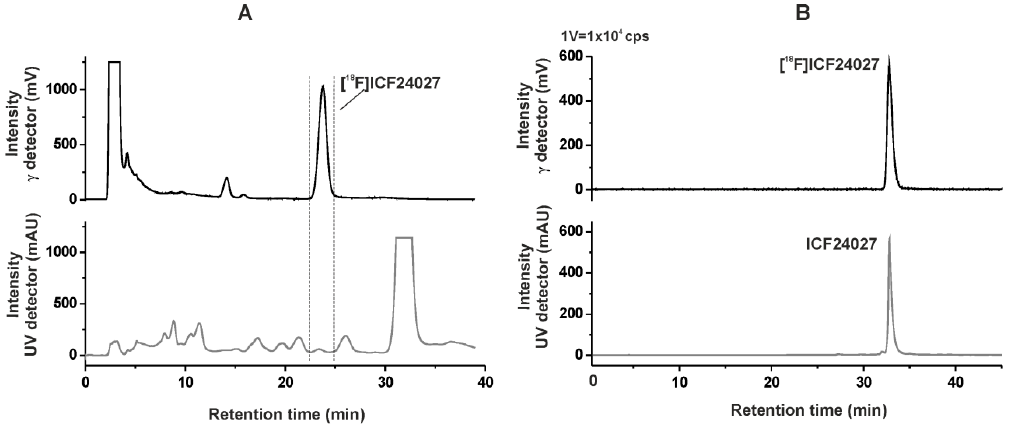
Figure 2. ( A ) Semi-preparative radio- and UV-HPLC chromatograms of [ 18 F] ICF24027 (conditions: Reprosil-Pur C18-AQ, 250 mm × 10 mm, 62% ACN/20 mM NH 4 OAc aq. , 3.0 mL/min). ( B ) Analytical radio- and UV-HPLC chromatograms of the final product of [ 18 F] ICF24027 spiked with the nonradioactive reference ICF24027 (conditions: Reprosil-Pur C18-AQ, 250 mm × 4.6 mm, gradient with eluent mixture of ACN/20 mM NH 4 OAc aq., 1.0 mL/min).